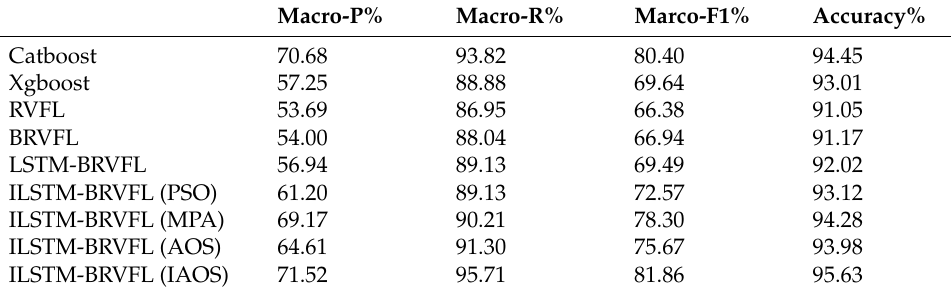
Figure 12. Confusion matrix for the ILSTM-BRVFL for the prediction of the three sets of logging data: ( a ) confusion matrix of w 1 ; ( b ) confusion matrix of w 2 ; ( c ) confusion matrix of w 3 . Table 5. Evaluation indicators of the contrast model on w 1 .